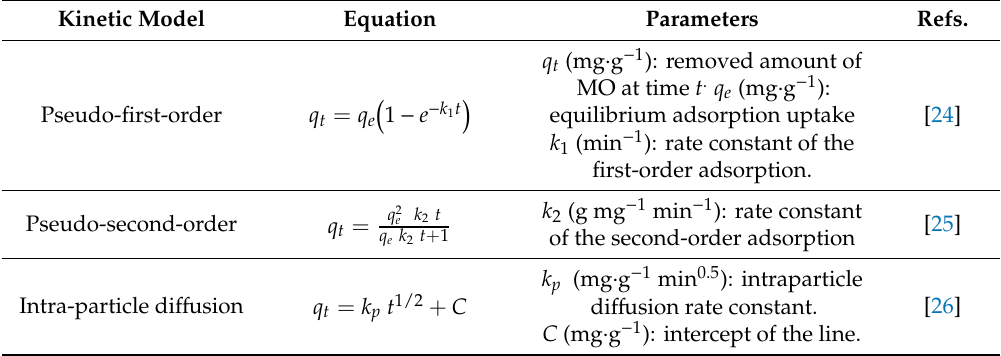
Table 2. Kinetic models used to fit the adsorption of methyl orange (MO) on adsorbent Mn–mica. Kinetic